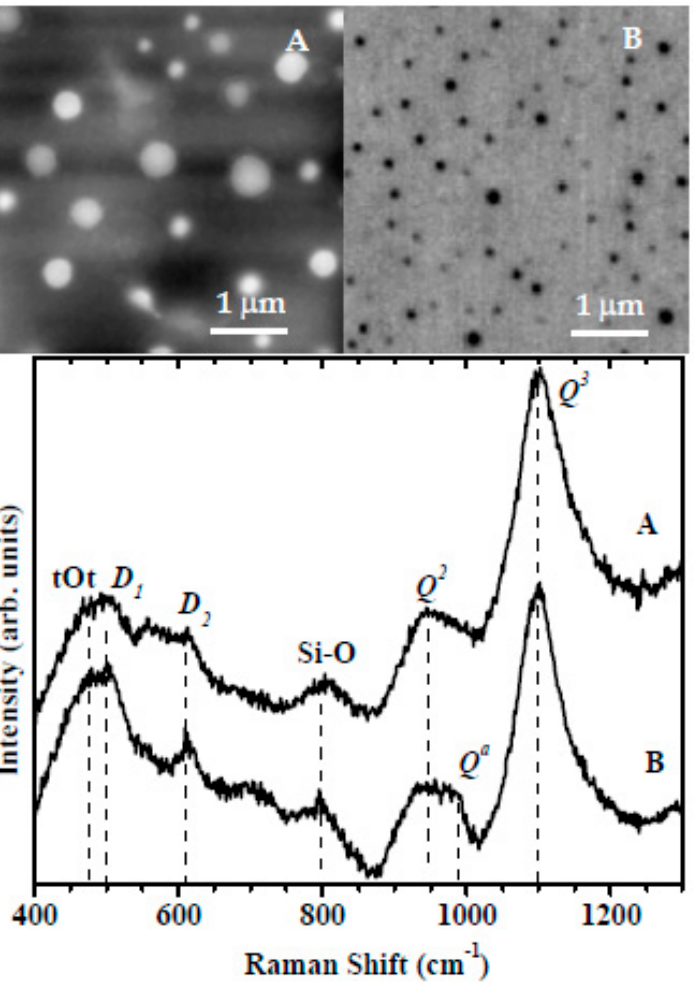
Figure 6. Optical micrographs and µ -RS from hybrid films (glass substrates coated with silica material (sample A) and with silver-based silica material (sample B)).